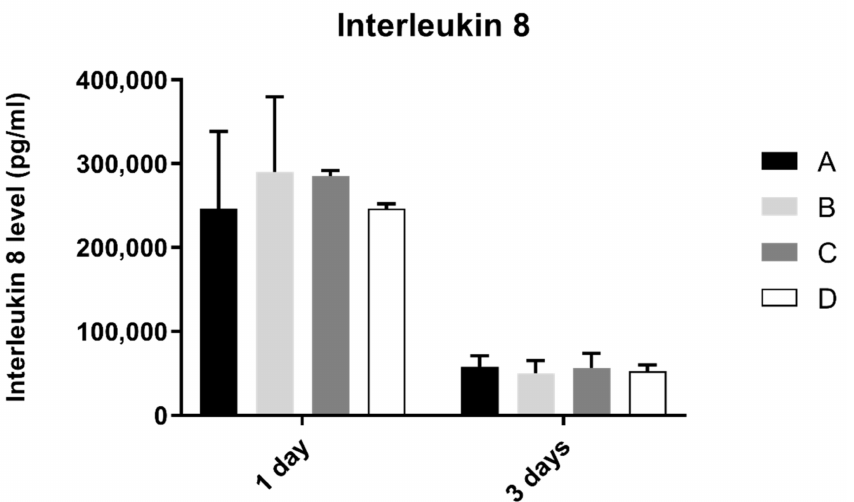
Figure 8. Interleukin 8 concentration (pg/mL) obtain in fibroblasts at 1 and 3 days (N = 4), presented as mean and standard deviation (error bars), for each study group (as described in Table 1). A Kruskal–Wallis test, followed by Dunn’s post-hoc tests, was used for comparison between study groups. Statistical significance: p <